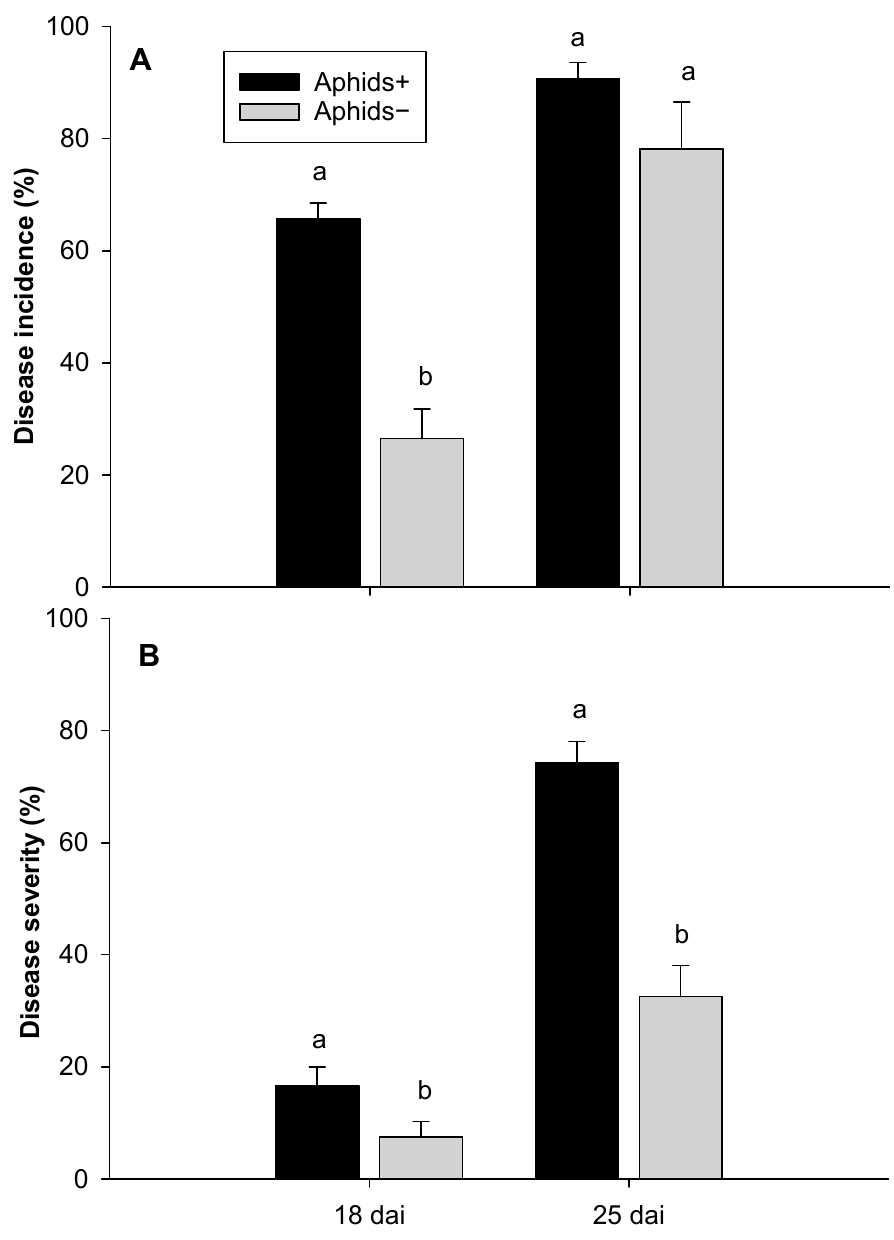
Figure 4. Stagonospora nodorum blotch 18 and 25 days after inoculation (dai): Disease incidence ( A ) and disease severity ( B ) on aphid ( Rhopalosiphum padi) infested (Aphids+) and non-infested (Aphids − ) plants from experiment 3. Error bars are standard error of the mean values and bars with different letters are different according Tukey’s test at p = 0.05.